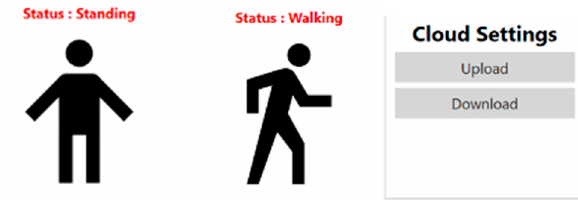
Figure 9. Status preview and cloud settings of the GUI client.